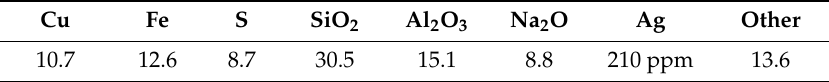
Table 5. Chemical composition of desilicated copper concentrate, wt. %.